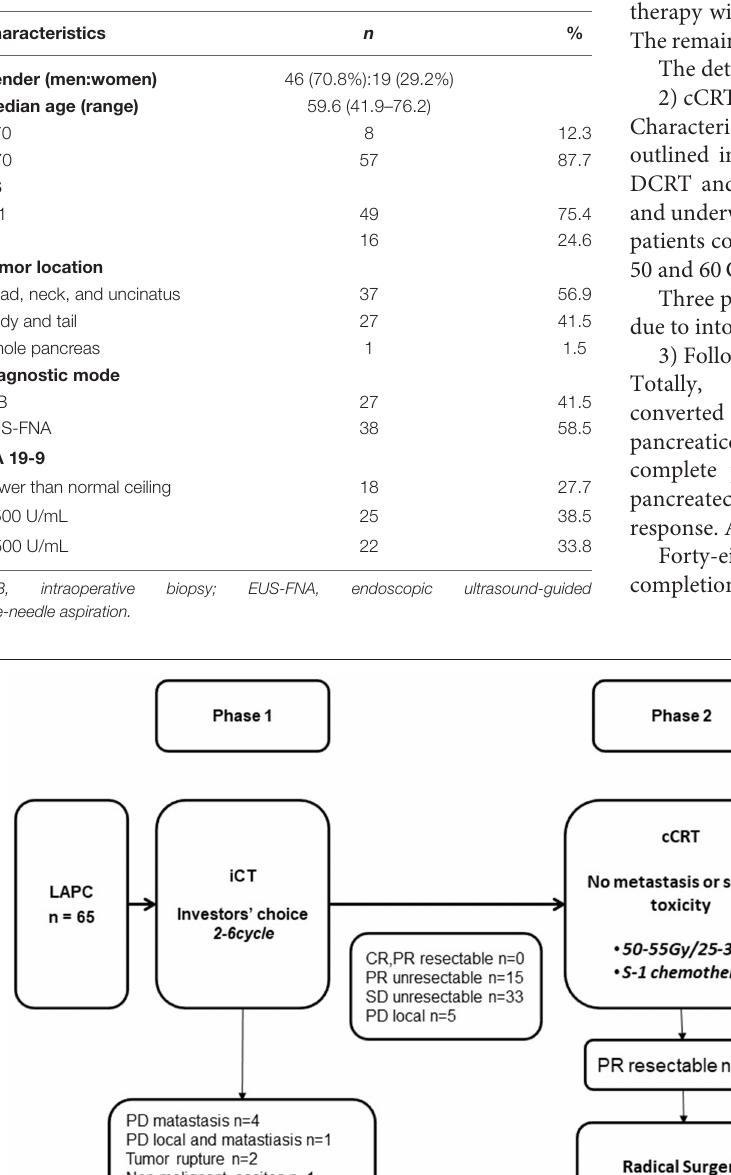
TABLE 1 | Patients’ characteristics of all patients ( n = 65).